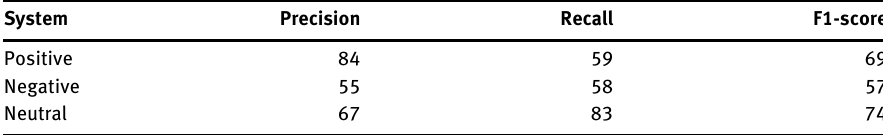
Table 8: Proposed Hybrid Approach Performance with Additional Features on Test Data for Each Class. System